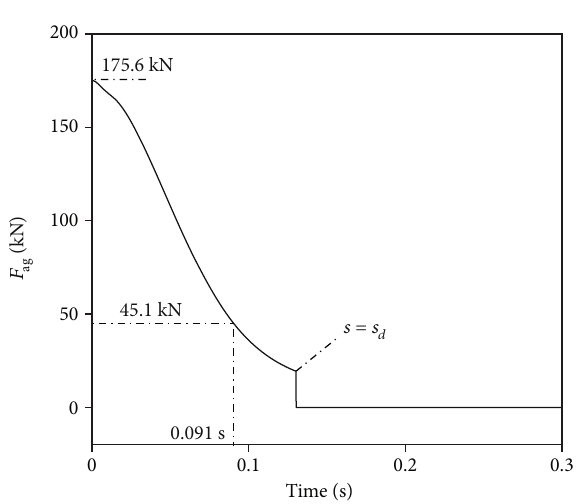
Figure 5: Time history of high-pressure cavity force.